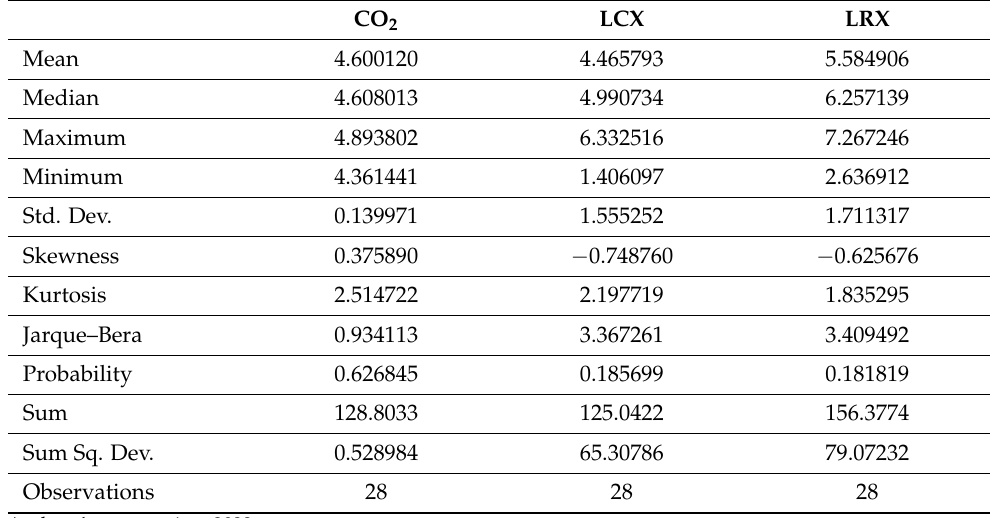
Table 1. Summary